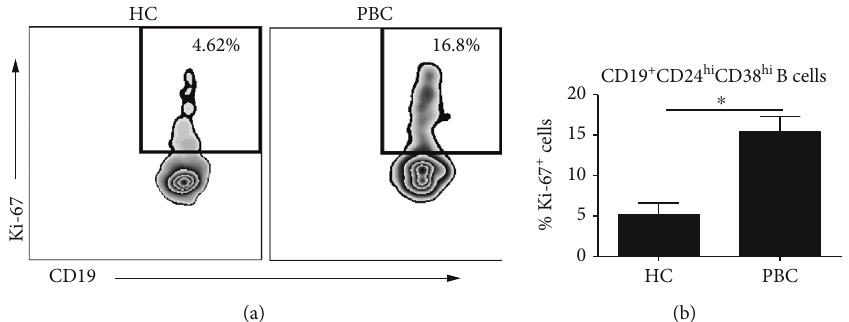
Figure 2: CD19 + CD24 hi CD38 hi B cells were highly proliferative from PBC patients compared to HC subjects. PBMC samples were stained with B cell surface markers CD19, CD24, and CD38. Intranuclear marker of proliferation was Ki-67. (a) Representative fl ow cytometric dot plots of Ki-67 expression in CD19 + CD24 hi CD38 hi B cells from PBC patients and HC subjects. (b) The frequency of Ki-67 + B cells summarized for CD19 + CD24 hi CD38 hi B cells from PBC patients and HC subjects; ∗ P < 0 : 05 .